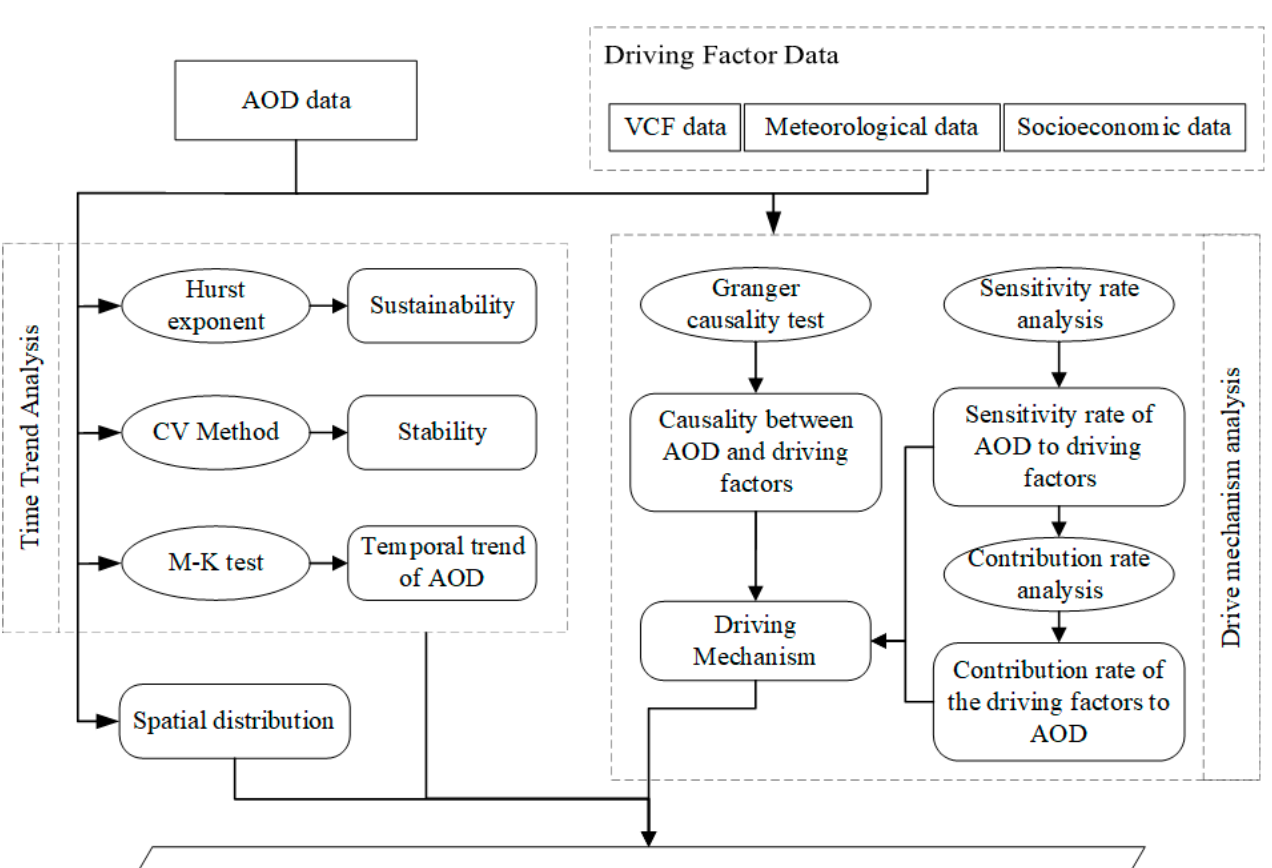
Figure 3. Overall technical flowchart.